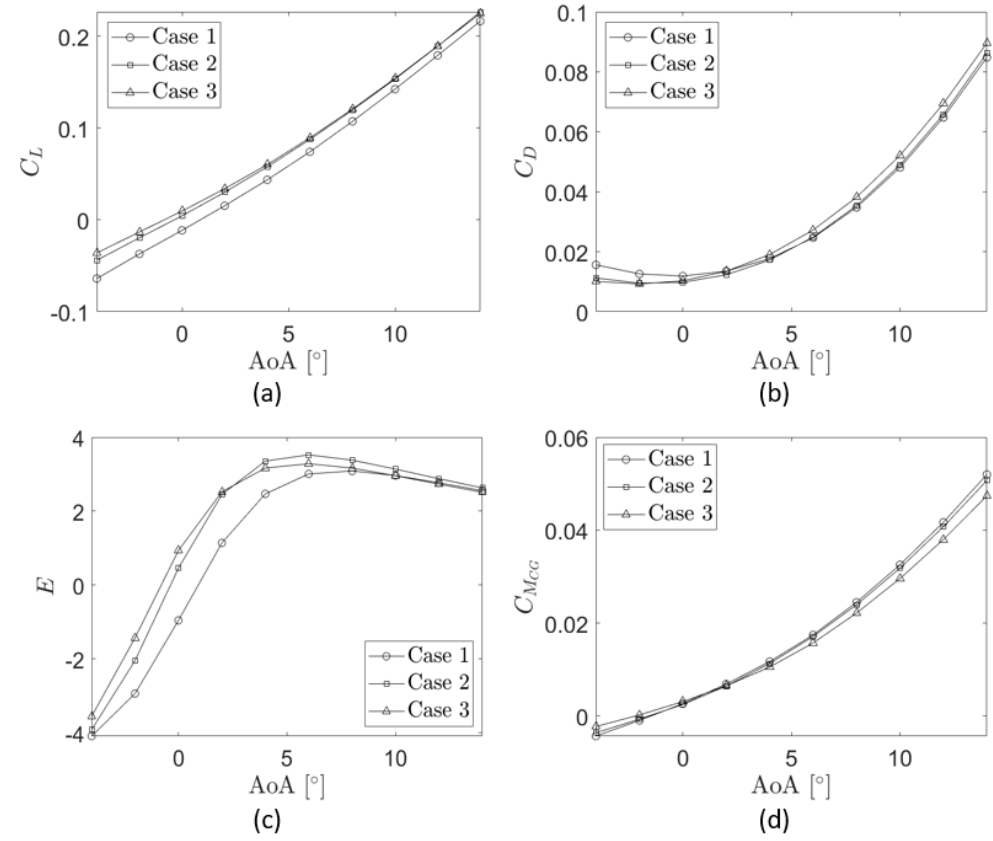
Figure 16. Aerodynamic parameters in terms of the angle of attack of the three CFD cases, ( a ) C L vs.